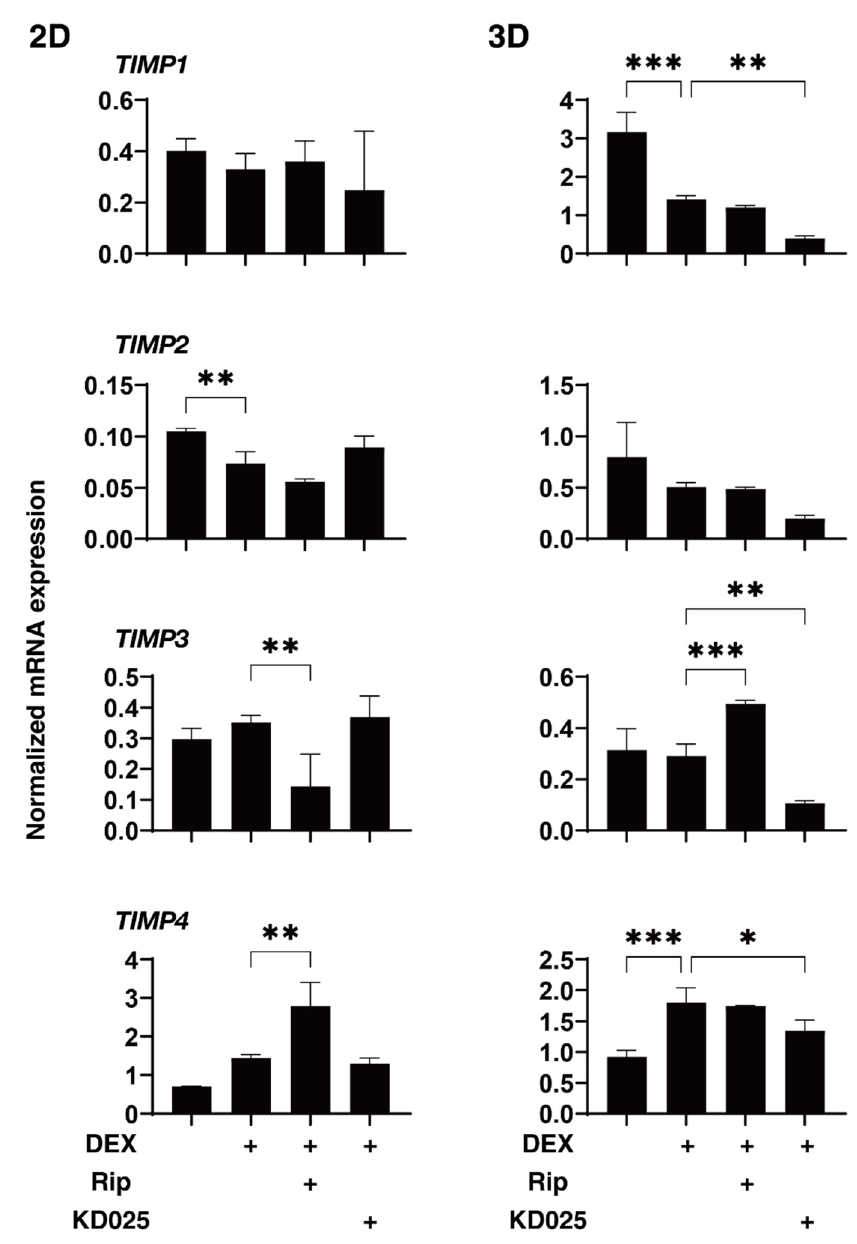
Figure 5. mRNA expression of TIMPs in 2D- and 3D-cultured HTM cells. On Day 6, HTM 2D cells and 3D spheroids (non-treated control; NT) and those treated with 250 nM DEX in the absence or presence of 10 µ M ripasudil (Rip) or KD025 were subjected to qPCR analysis to estimate the expression of mRNA in TIMP1–4 . All experiments were performed in duplicate using 3 different confluent 6-well dishes (2D) or 15–20 freshly prepared 3D HTM spheroids (3D) in each experimental condition. Data are presented as the arithmetic mean ± standard error of the mean (SEM). * p < 0.05, ** p < 0.01, *** p < 0.005 (ANOVA followed by a Tukey’s multiple comparison test).